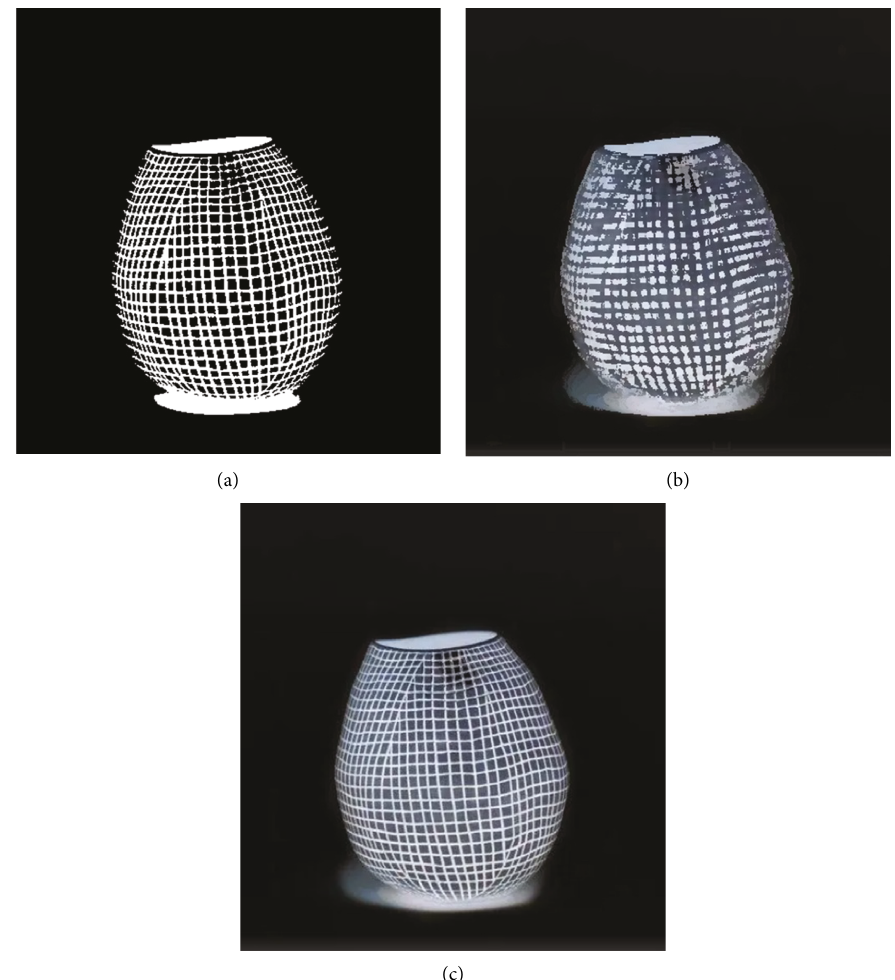
Figure 7: Example of appearance design of ceramic art. (a) Sketch design. (b) Preliminary rendering. (c) Finished product